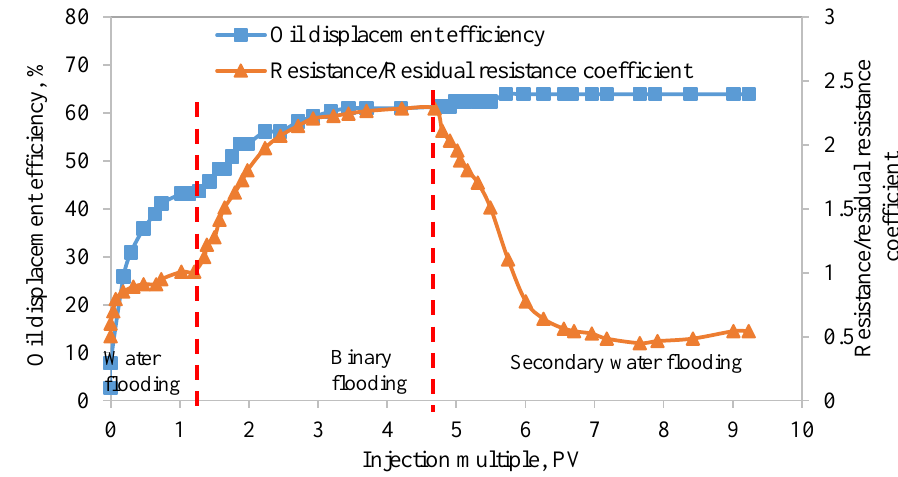
Figure 6—Core displacement experiment of binary system.